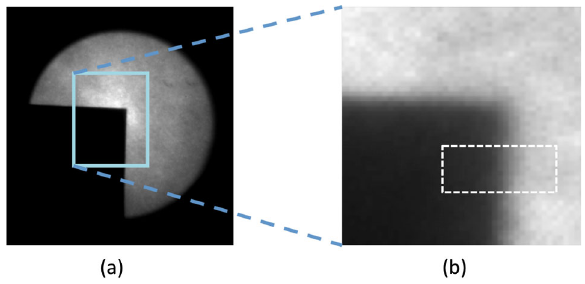
FIG. 5. (a) Resolution target; left: full view, right: (b) Expanded ( (cid:3) 16 )